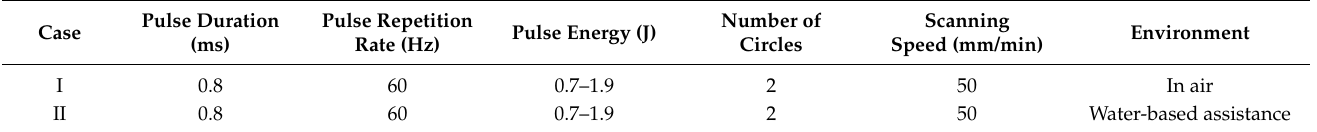
Table 1. Laser parameters used in air and water-based assistance.